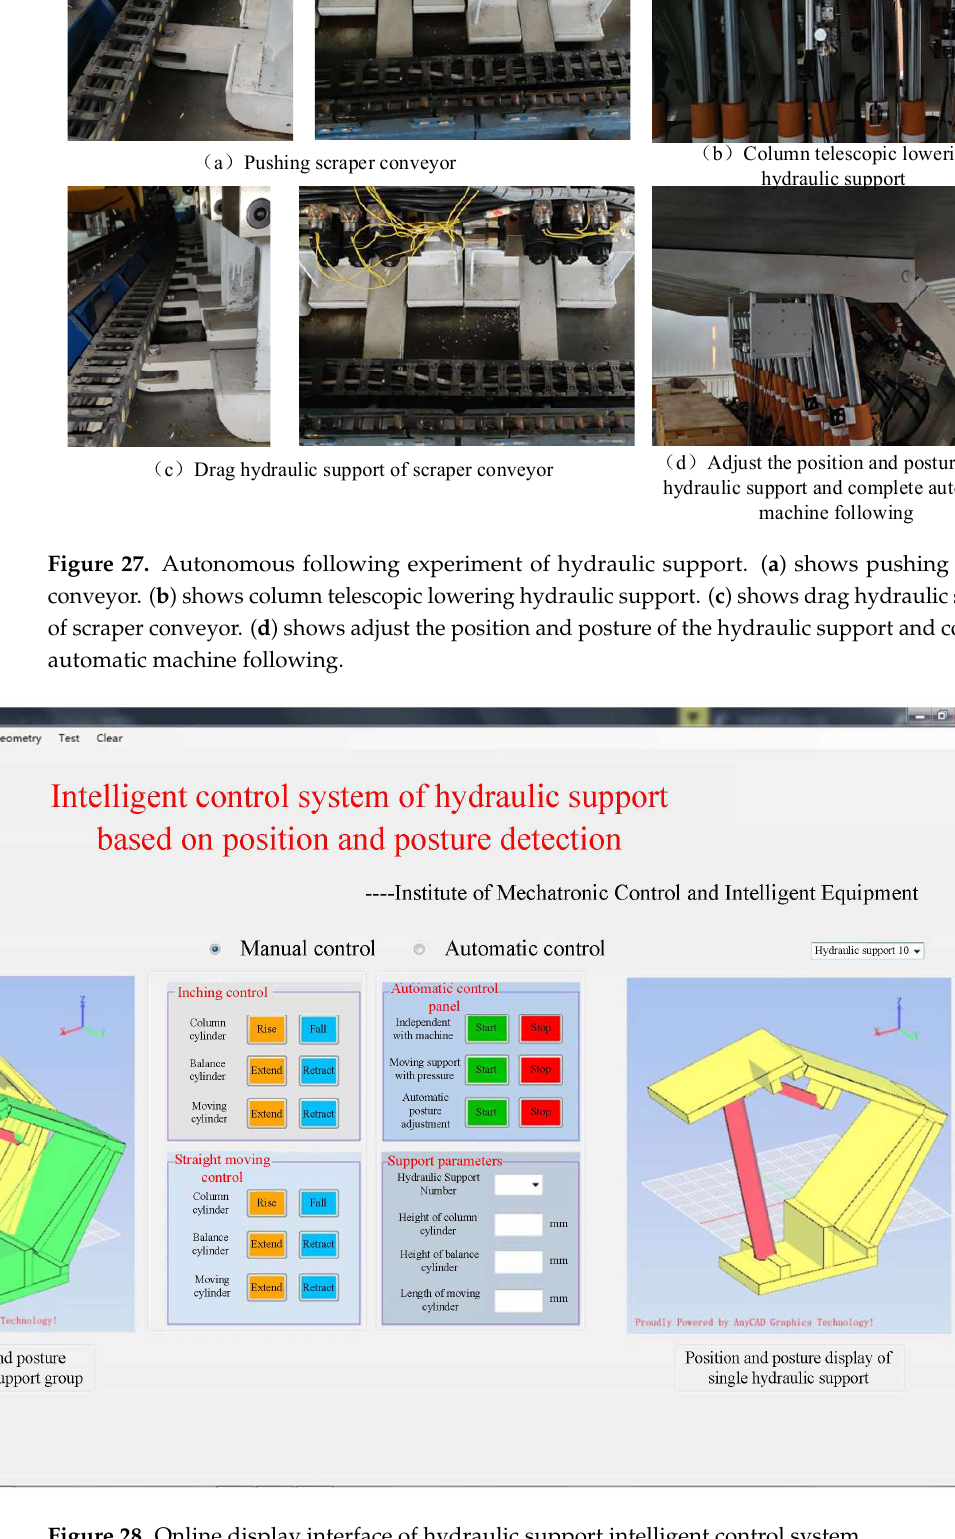
Figure 28. Online display interface of hydraulic support intelligent control system.